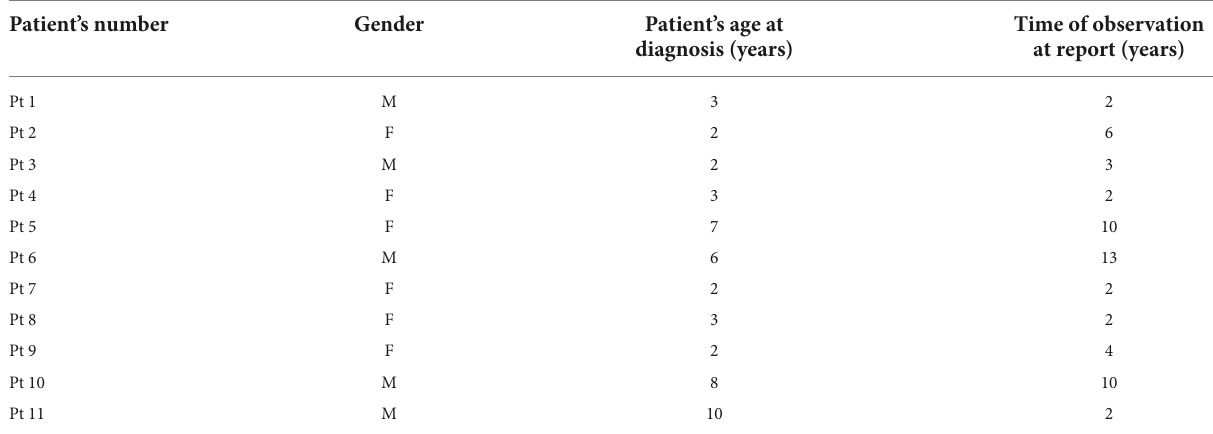
TABLE 2 Demographic data of ataxia-telangiectasia (A-T) patients and the time of observation by a pediatric radiologist. Demographic data of A-T patients Patient’s number